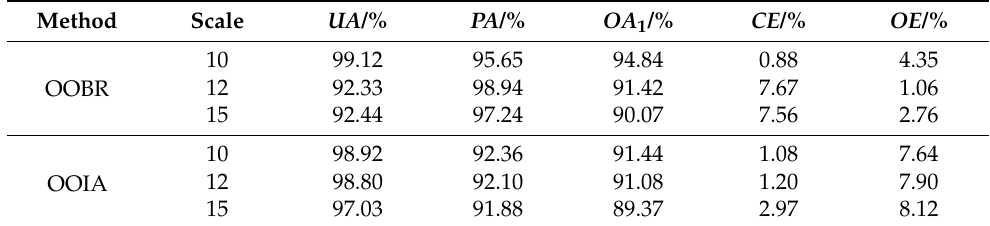
Table 5. Accuracy of the two methods with different segmentation